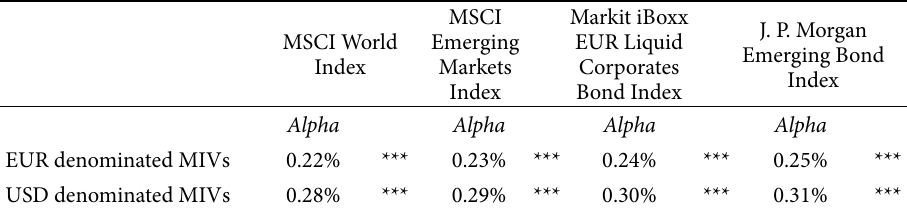
Markit iBoxx EUR